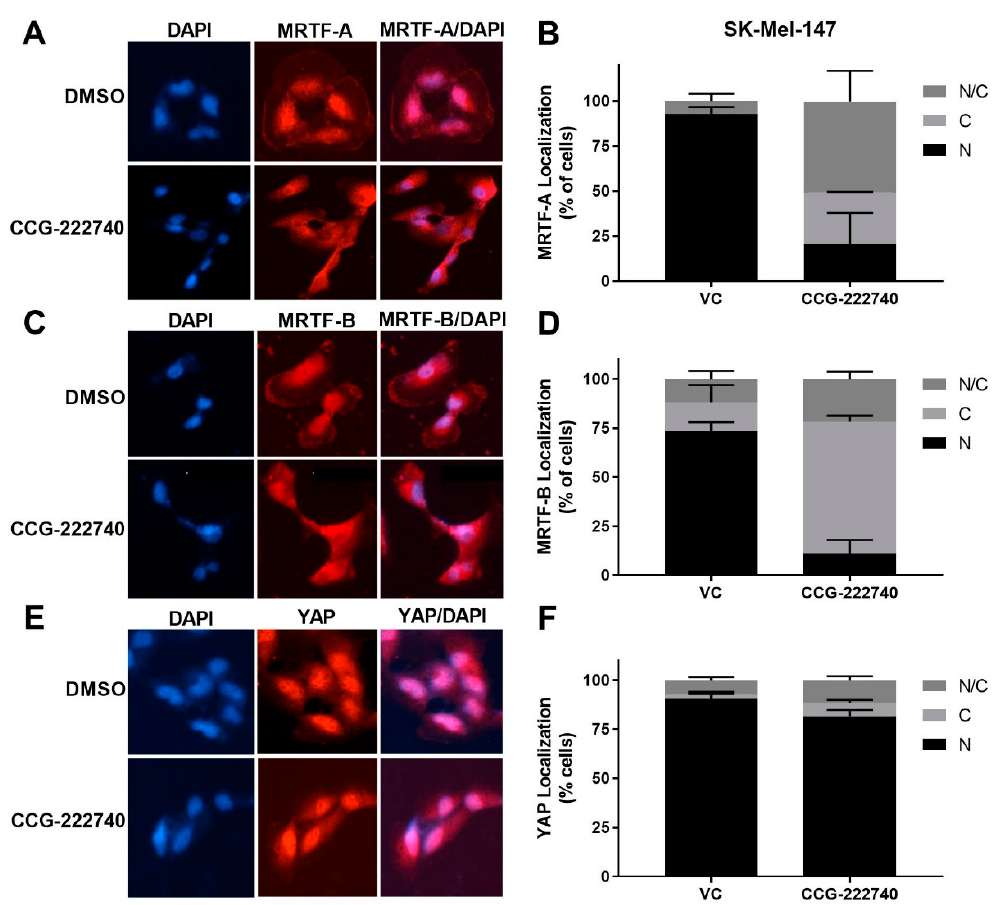
Figure 4. CCG-222740 disrupts nuclear localization of MRTF-A and MRTF-B but not YAP1. ( A ). Cellular localization of MRTF-A was determined in SK-Mel-147 cells by immunofluorescence following 24-h treatment with vehicle control (VC) 0.1% DMSO or 10 µM CCG-222740 in the presence of 10% FBS. ( B ). Quantification of MRTF-A cellular localization was determined by scoring individual cells as exclusively nuclear (N), cytosolic (C), or even distribution (N/C). Counts were determined from two independent experiments with at least 100 cells scored blindly for each condition (n = 2, >100 cells each determination). ( C ). Cellular localization of MRTF-B was determined in SK-Mel-147 cells as indicated above for MRTF-A. ( D ). Quantification of MRTF-B cellular localization was determined as indicated above for MRTF-A (n = 2, >100 cells each determination). ( E ). Counts are from cellular localization of YAP1 was determined in SK-Mel-147 cells as stated above for MRTF-A. ( F ). Quantification of YAP1 cellular localization was determined as indicated above for MRTF-A except that counts are from three independent experiments, n = 3, with at least 100 cells scored blindly for each